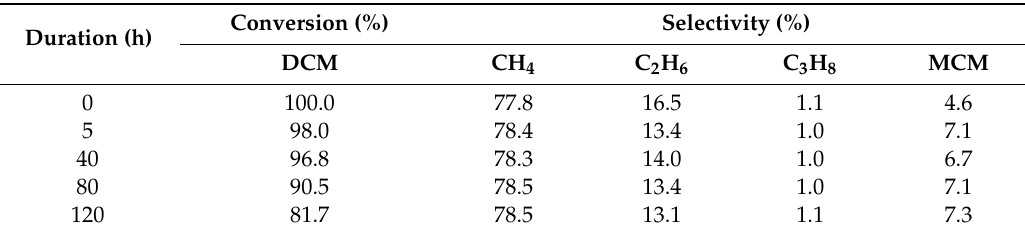
Table 1. Catalytic activity at the end of the experiments performed at di ff erent times on